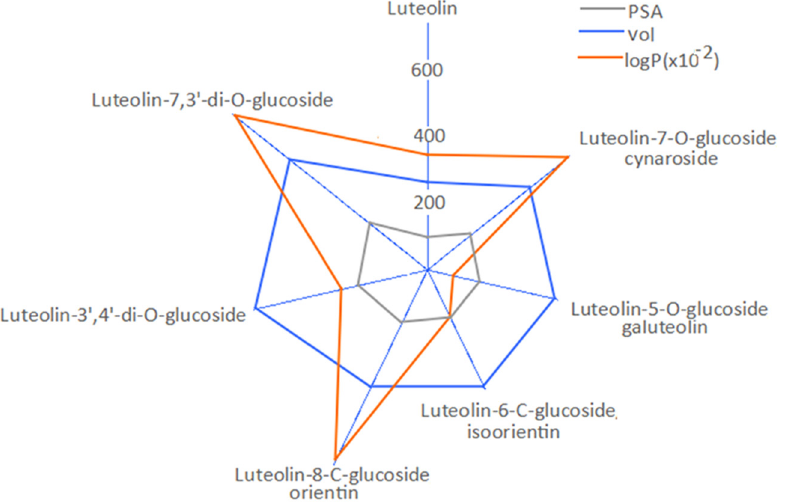
Figure 6: The correlation between molecular volume ( vol ) , PSA and water – octanol partition coe ffi cient ( log P ) for several common luteolin